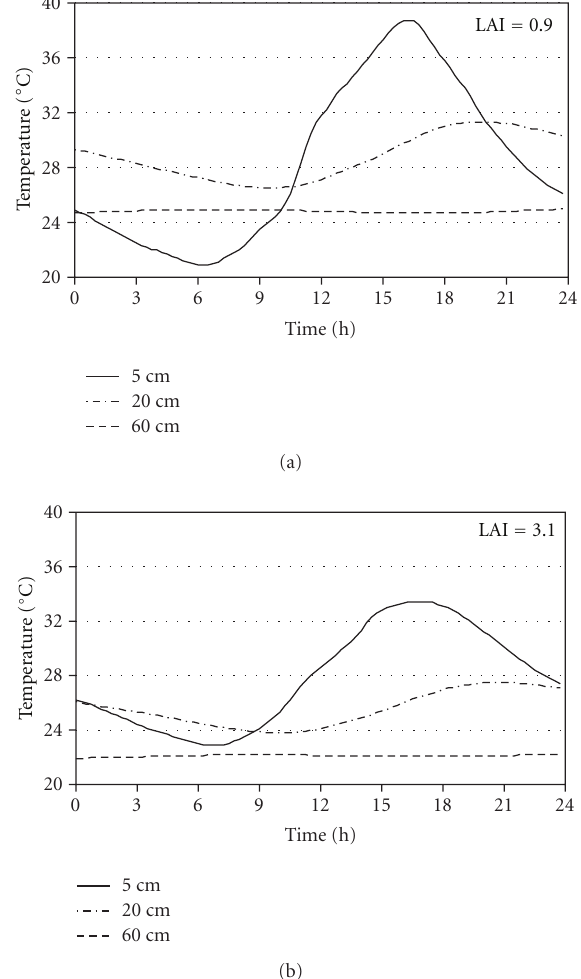
Figure 2: E ff ect of leaf are index (LAI) on the soil temperature dynamics at di ff erent depths in a non-fertilized (to the left) and in a fertilized parcel (to the right) on 14/07/2011 at ˝Orbotty´an,